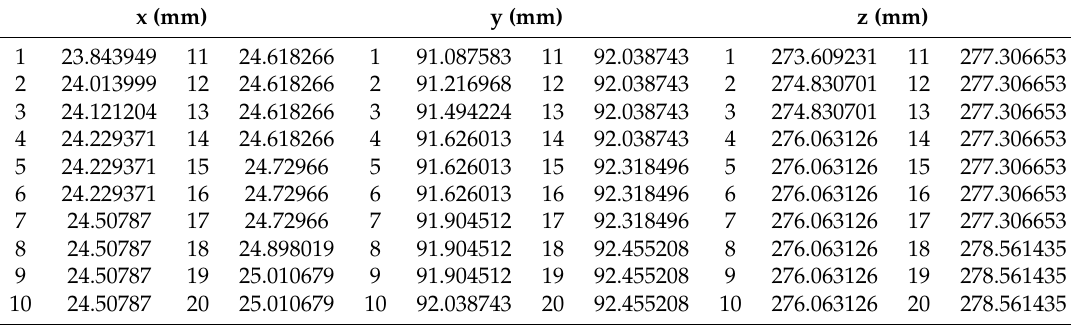
Table 6. The 20 spatial coordinates determined with the inverse kinematics (IK) model for a